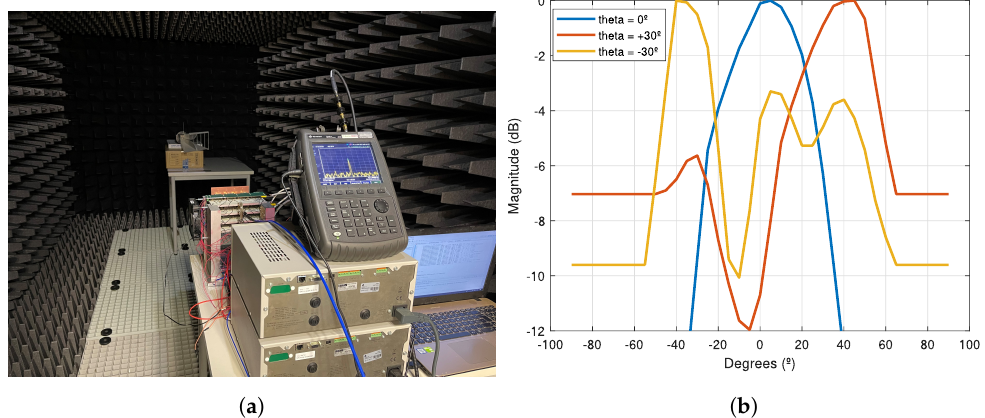
Figure 11. Transmitter Radiation Pattern for different Azimuth Angles and respective Measurement Setup. ( a ) Measurement Setup in Anechoic Chamber. ( b ) Radiation